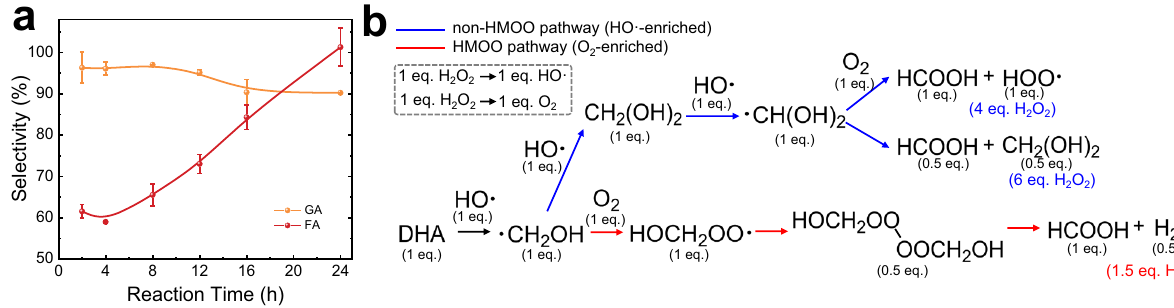
Fig. 5 Products selectivity and reaction pathways analysis. a Selectivity pro fi le over MnO 2 /Goe-1% catalyst as a function of time (the change in the concentrations of DHA, GA, and FA was shown in Supplementary Fig. 16). Error bars represent standard deviations from triplicate experiments. b Stoichiometric analysis of H 2 O 2 required to produce 1 molar equivalent FA based on the